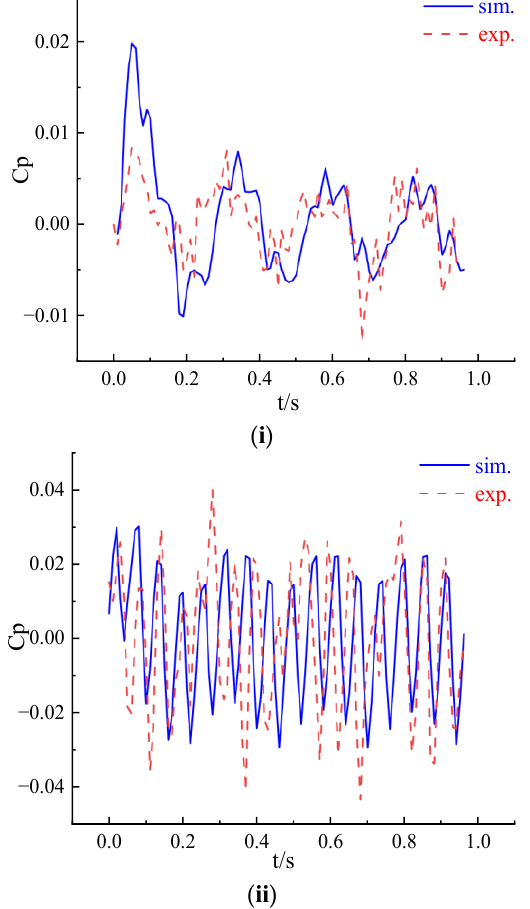
Figure 8. Comparison of experimental and numerical simulation results. ( i ) Time-domain diagram of the inlet pressure pulsation of pre-guide vanes. ( ii ) Time-domain diagram of the runner inlet pressure pulsation. ( iii ) The frequency domain diagram of the inlet pressure pulsation of the front guide vane. ( iv ) Frequency domain diagram of the runner inlet pressure